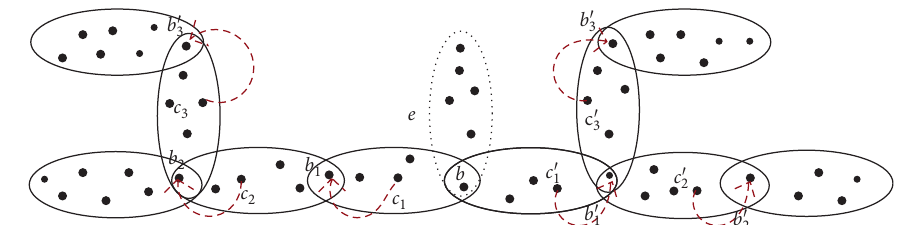
Figure 3: A k -uniform hypertrees T